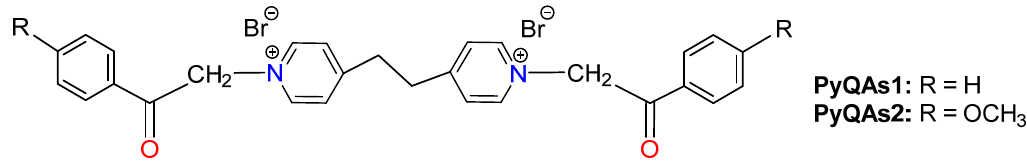
Figure 1. Structure of the two diquaternary salts of bis(pyridinium) (PyQAs) used in the assisted formation of ZnO NPs.